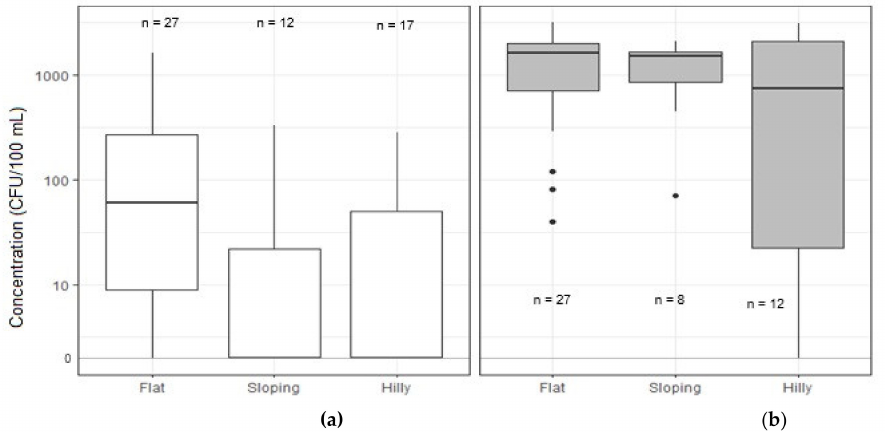
Figure 7. ( a ) E. coli and ( b ) TC in flat, hilly, and sloping